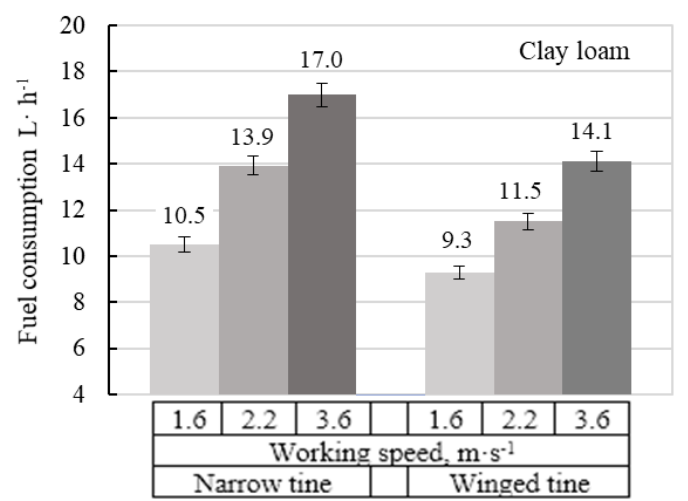
Figure 11. Dependence of hourly fuel consumption on speed and tine types on clay loam soil.